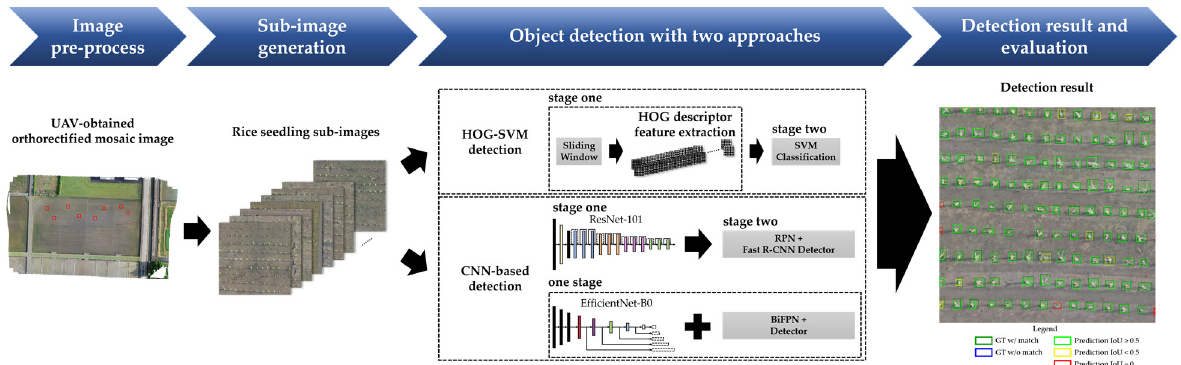
Figure 4. The framework of rice seedling detection.